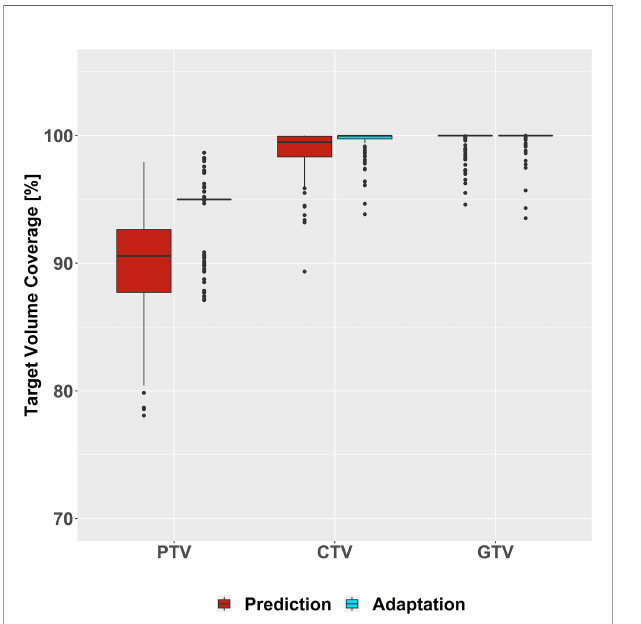
FIGURE 3 | Target Volume Overdose. The relative planning target volume (PTV) that received a radiation dose above the dose maximum is shown before (red) and after (blue) plan adaptation. Generally, a maximum volume of 1% was allowed to exceed the maximum dose (dashed line).